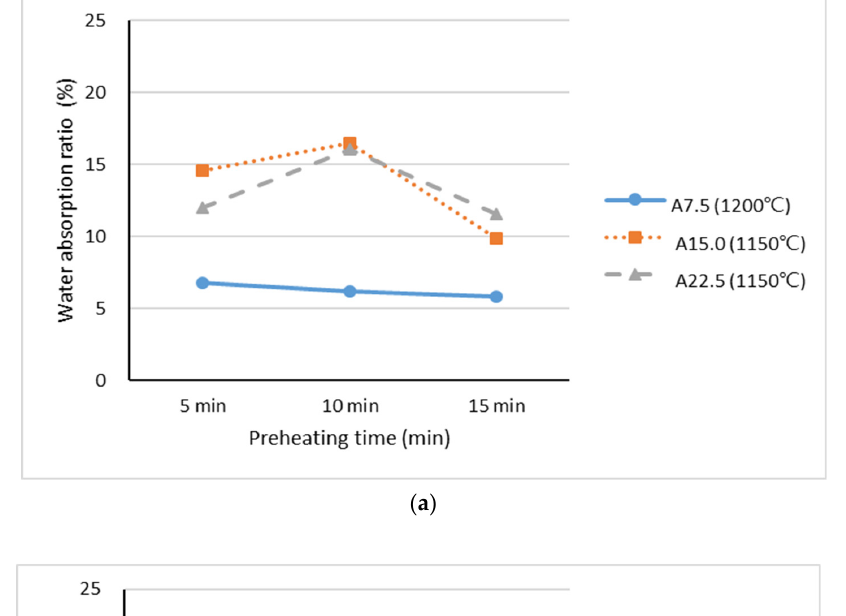
15 of 20 Figure 6. Particle density of lightweight aggregates at Stage II mixed with ( a ) Industrial Sludge A, ( b ) Industrial Sludge B, and ( c ) Industrial Sludge C. Lightweight aggregate requires prewetting to maintain as uniform a moisture con- tent as possible before other ingredients are added to the concrete. The proportioned vol- ume of the concrete is then maintained, and slump loss during transport is minimized or eliminated. According to the recommendation of ASTM C94/C94M, the water absorption ratio of lightweight aggregate should preferably be less than 20%. Figure 7 presents the water absorption ratios of the lightweight aggregates made with industrial sludge. The data show that, as the preheating time increased to 15 min, the water absorption of Sam- ples A and B dropped to 3–11%, while the water absorption of Sample C was reduced to 10–18%. The results indicate that increasing the preheating period led to a decrease in the water absorption ratio, which was an inverse trend relative to that for particle density; that is, aggregates with a lower particle density had a higher water absorption ratio. The aggregates sintered at 1200 °C (A7.5, B7.5, and B15) were considered to be of better quality because the water absorption ratios were lower than 10%; this was mainly because the higher sintering temperature resulted in the lightweight aggregates developing finer sur- face textures and fewer open pores, as shown in Figure 5. The lightweight aggregates con- taining Industrial Sludge C had higher water absorption ratios of between 10% and 21%, possibly because of the lower sintering temperature (1150 °C) and higher loss on ignition (70%) of Industrial Sludge C; the loss of matter during the sintering process tended to produce open pores on the surfaces of the aggregate, thereby increasing the water absorp- tion ratio. However, according to the standard that the water absorption ratio of light- weight aggregate suitable for use in concrete should less than 20%, except for sample C22.5, which exhibited a water absorption ratio of 21% after 5 min of preheating, the sam-